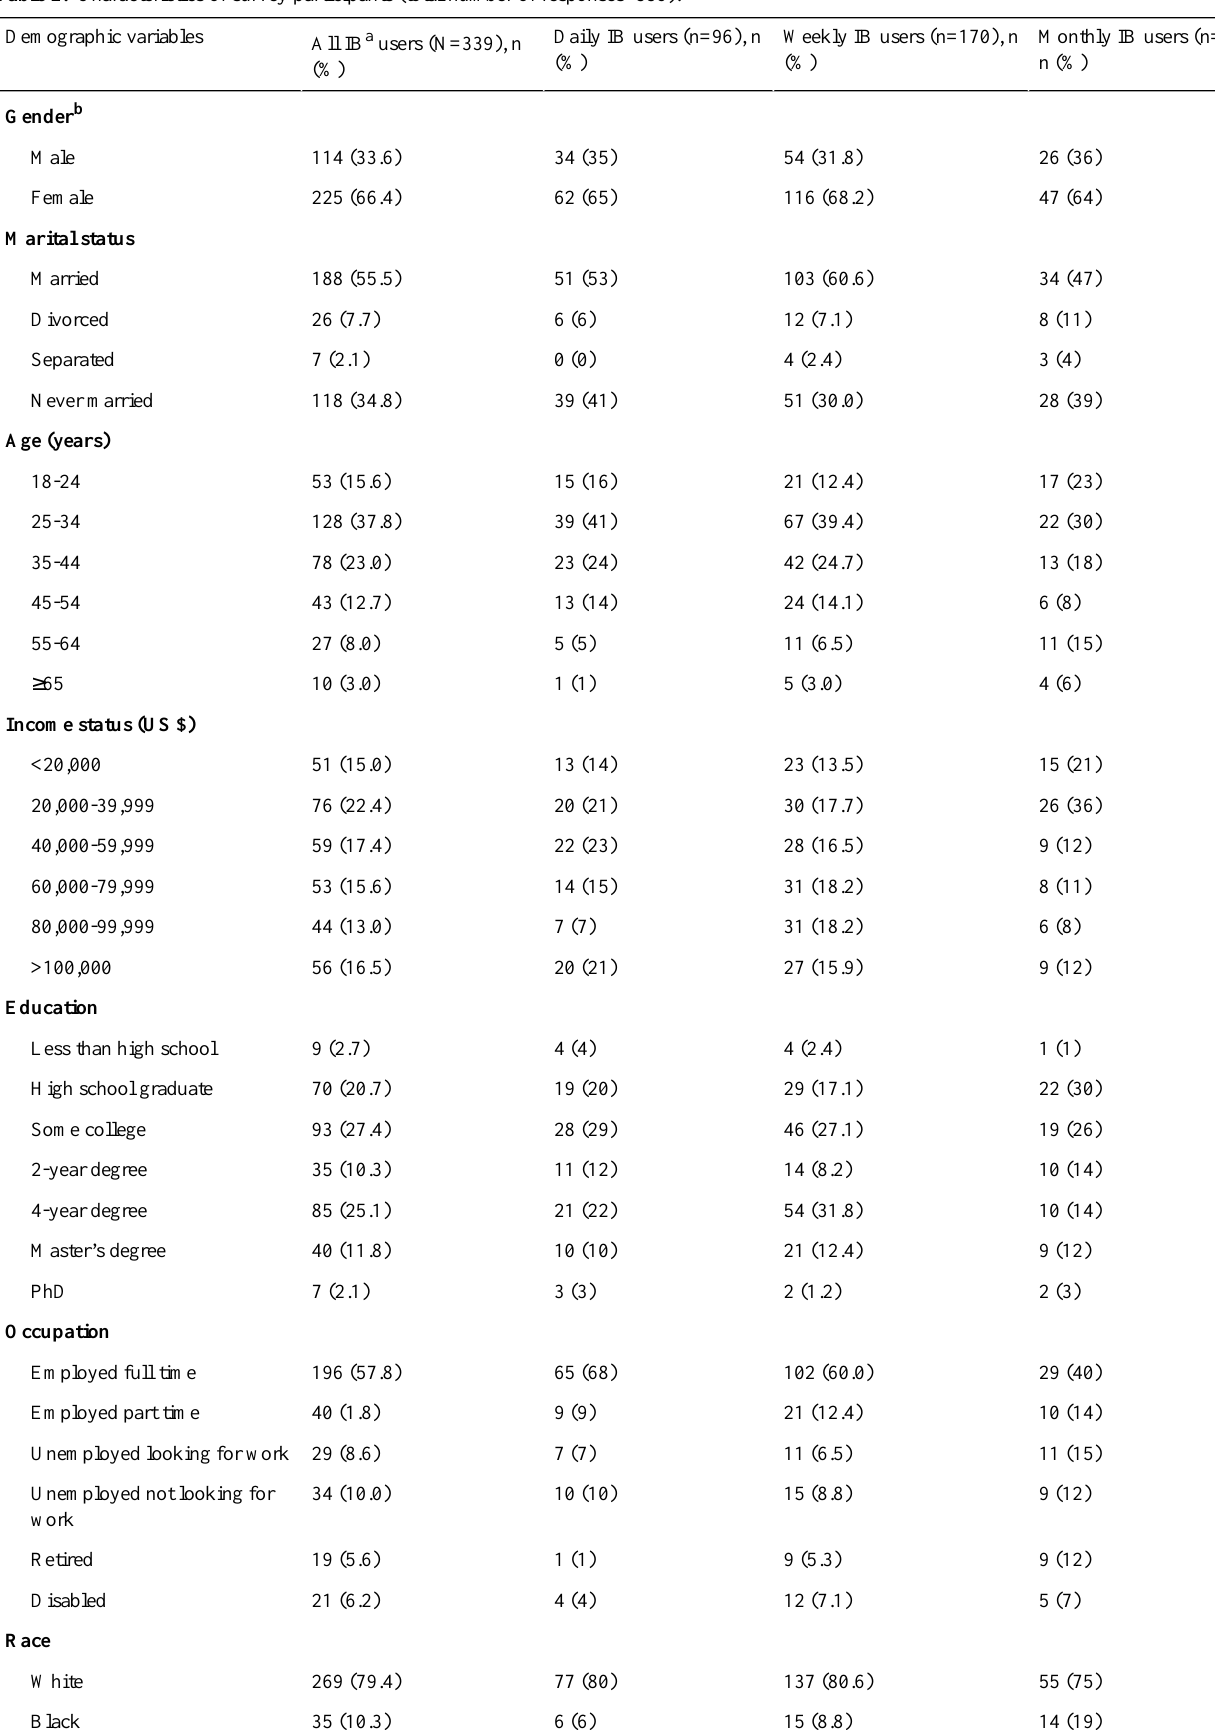
Table 2. Characteristics of survey participants (total number of responses=339).